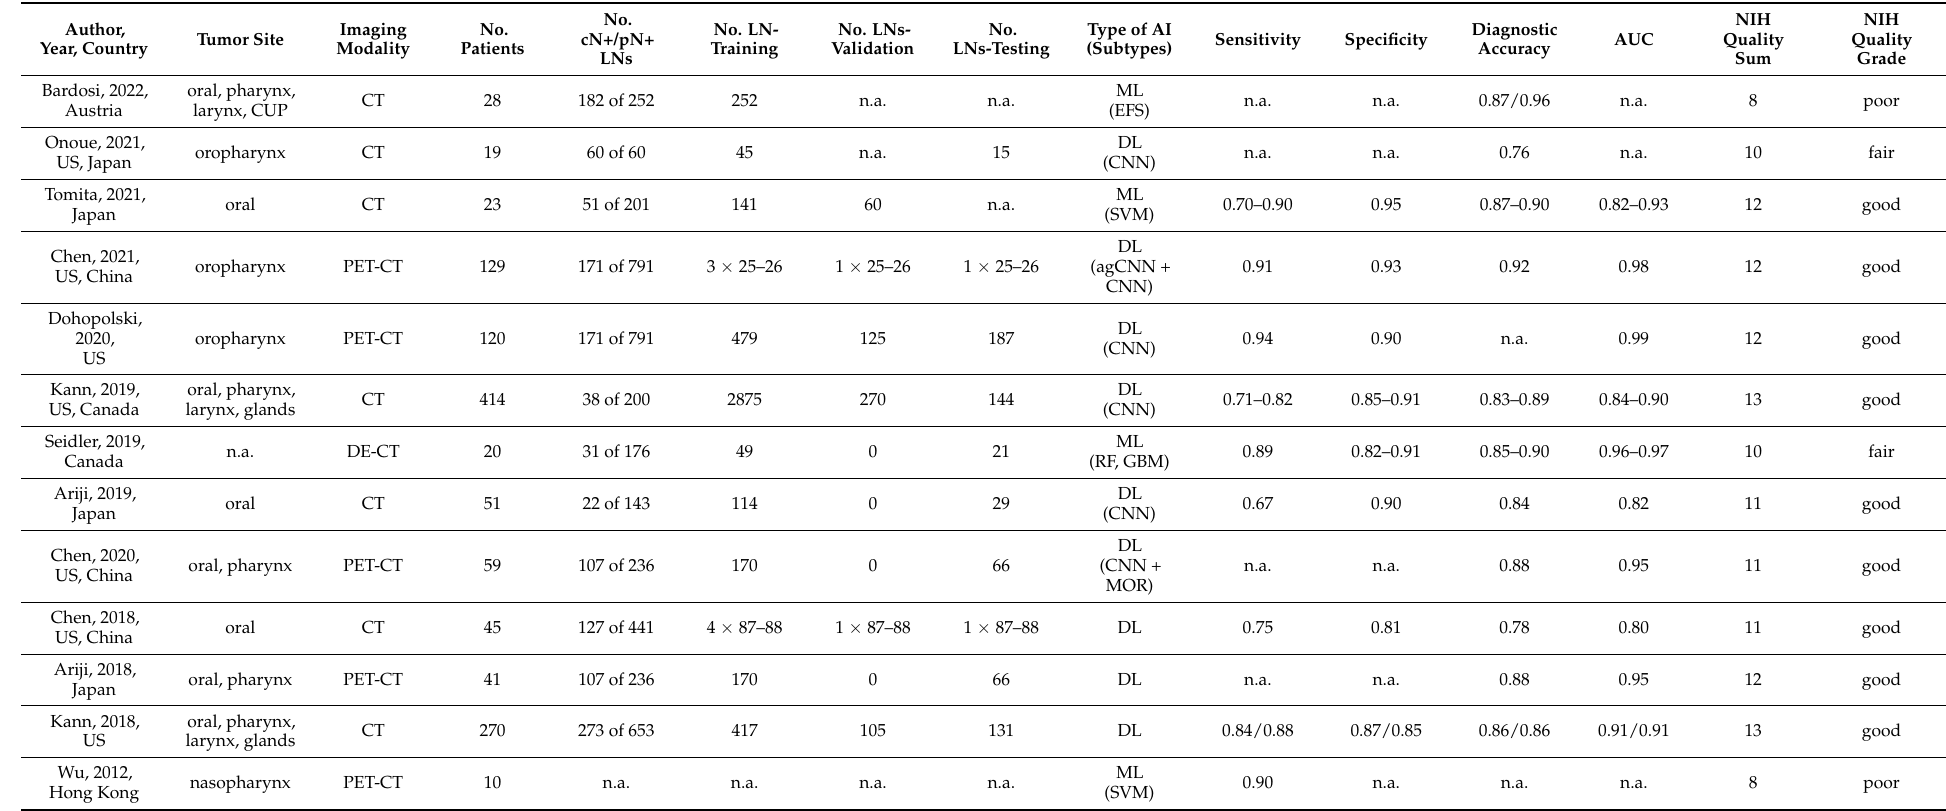
Table 2. Data extraction